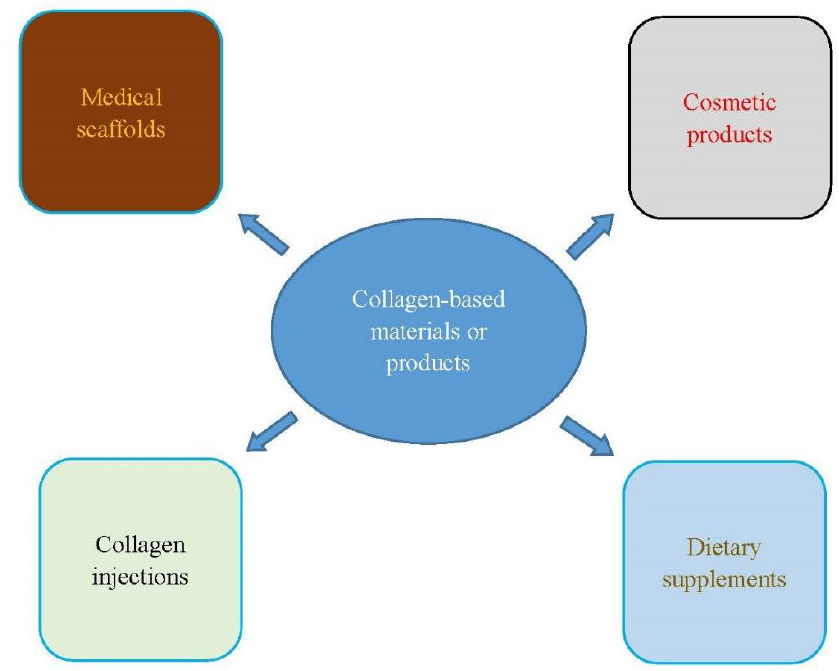
Figure 2. The functions of collagen-based biomaterials or products.